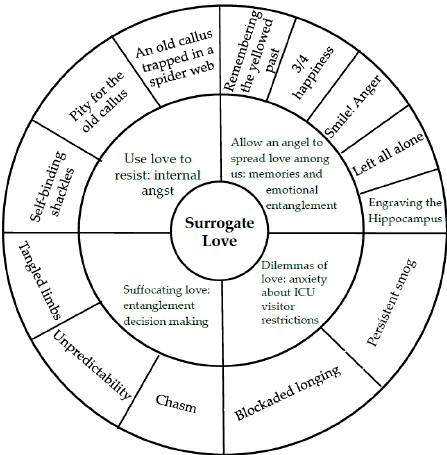
Figure 1. Themes and subthemes of surrogate decision-making process.